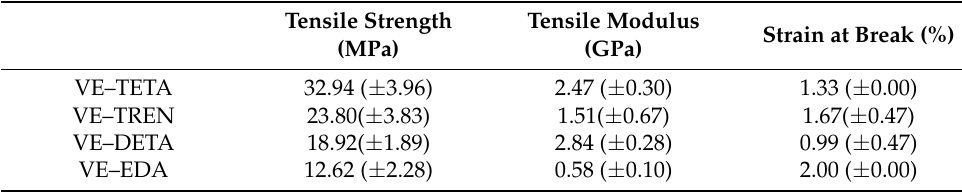
Table 5. Mechanical properties of different bioepoxy